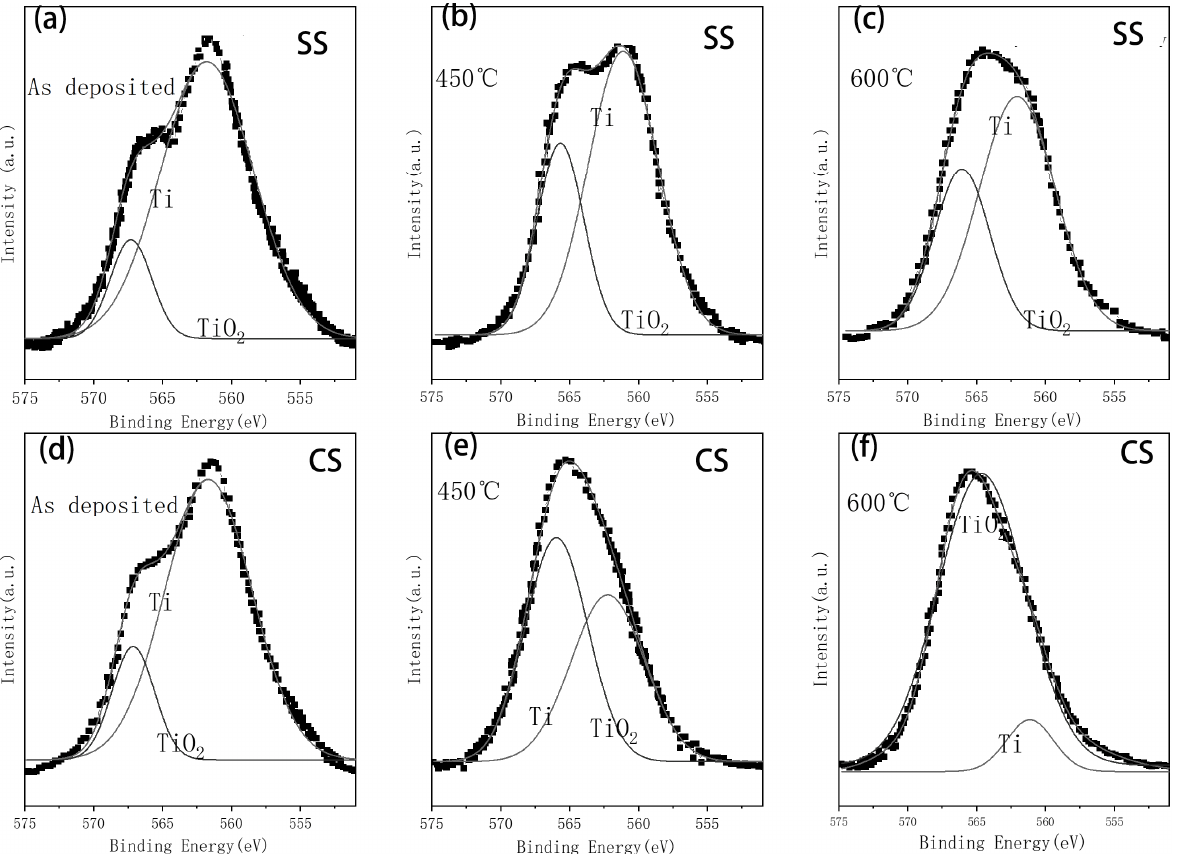
Figure 5. Ti 2s XPS spectra of ( a ) as deposited SS, ( b ) 450 °C-RTP treated SS, ( c ) 600 °C-RTP treated SS, ( d ) as deposited CS, ( e ) 450 °C-RTP treated CS and ( f ) 450 °C-RTP treated CS samples, respectively.